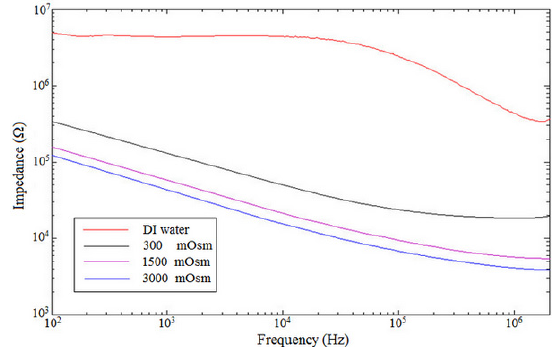
Figure 4. Impedance spectra of DI water and varying concentrations of PBS measured by impedance flow cytometry (IFC).